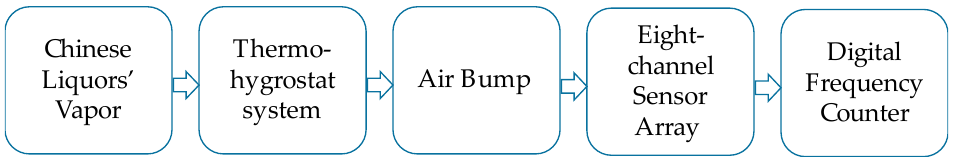
Figure 1. ( a ) Image of the e-nose; ( b ) Assembly diagram of the e-nose.